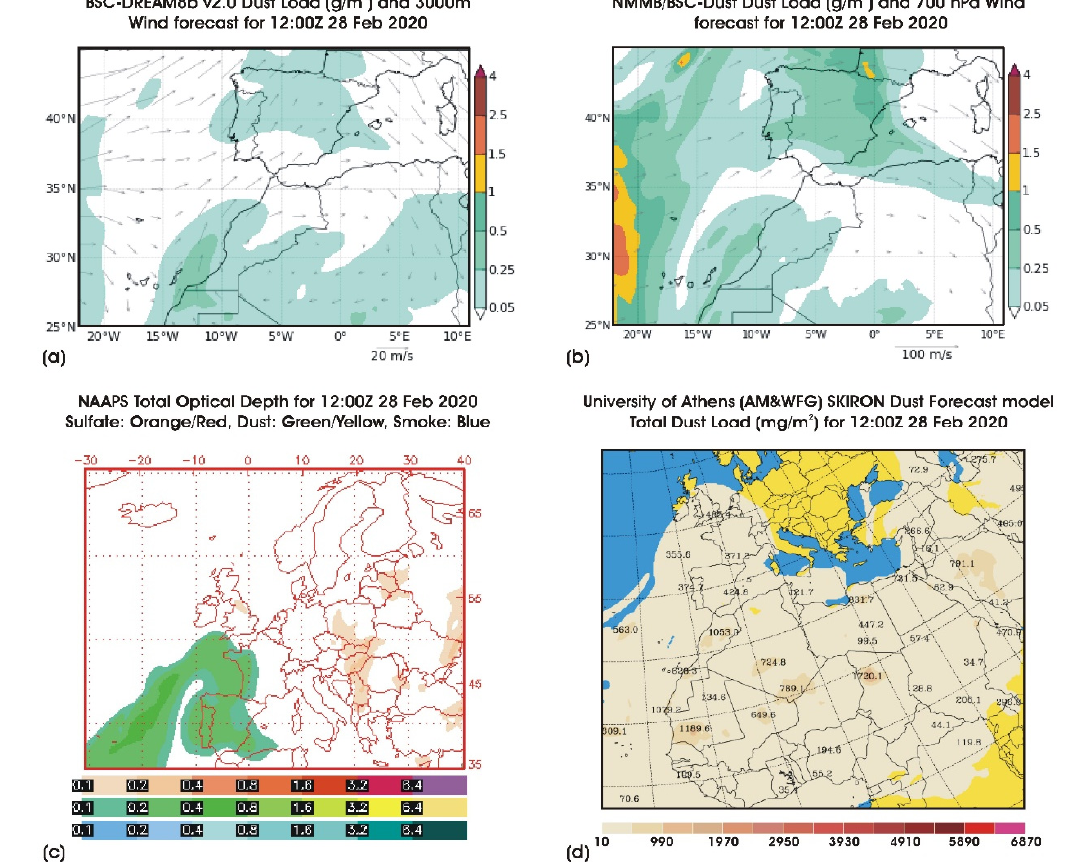
Figure 3. Maps of total dust load ( a , b , d ) and optical depth values ( c ) over the Iberian Peninsula predicted for 28 February by the BSC-DREAM8b v2.0 ( a ), NMMB / BSC ( b ), NAAPS ( c ), and SKIRON ( d ) dust models. Colored areas ( a – c ) and brown areas ( d ) point out the presence of mineral dust in the atmosphere. Arrows in panels ( a , b ) stand for wind direction.